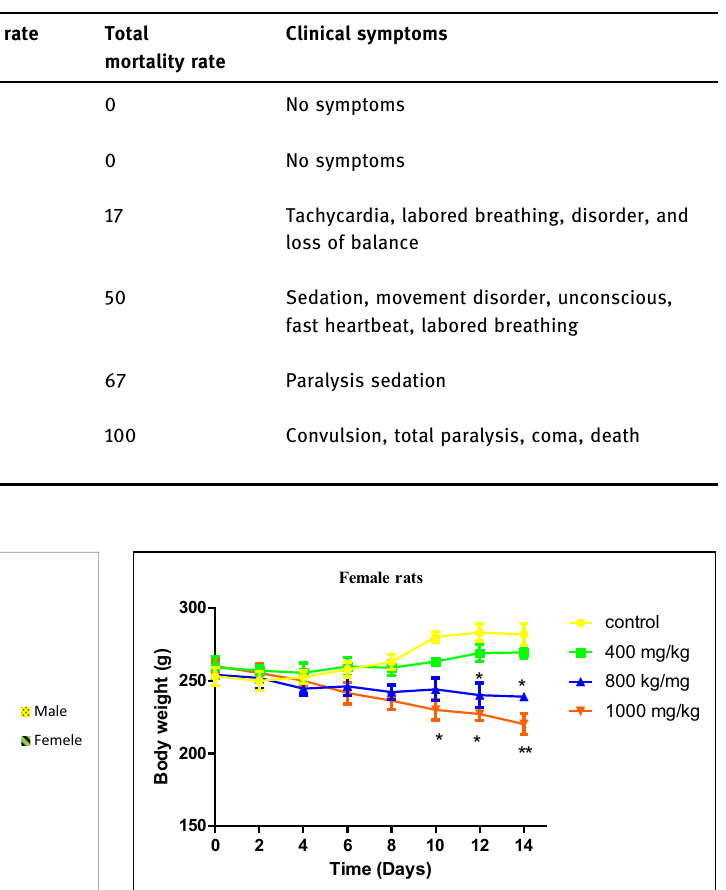
Table 2: Clinical symptoms occurred in animals treated with B. hispanica extracts under acute toxicity conditions